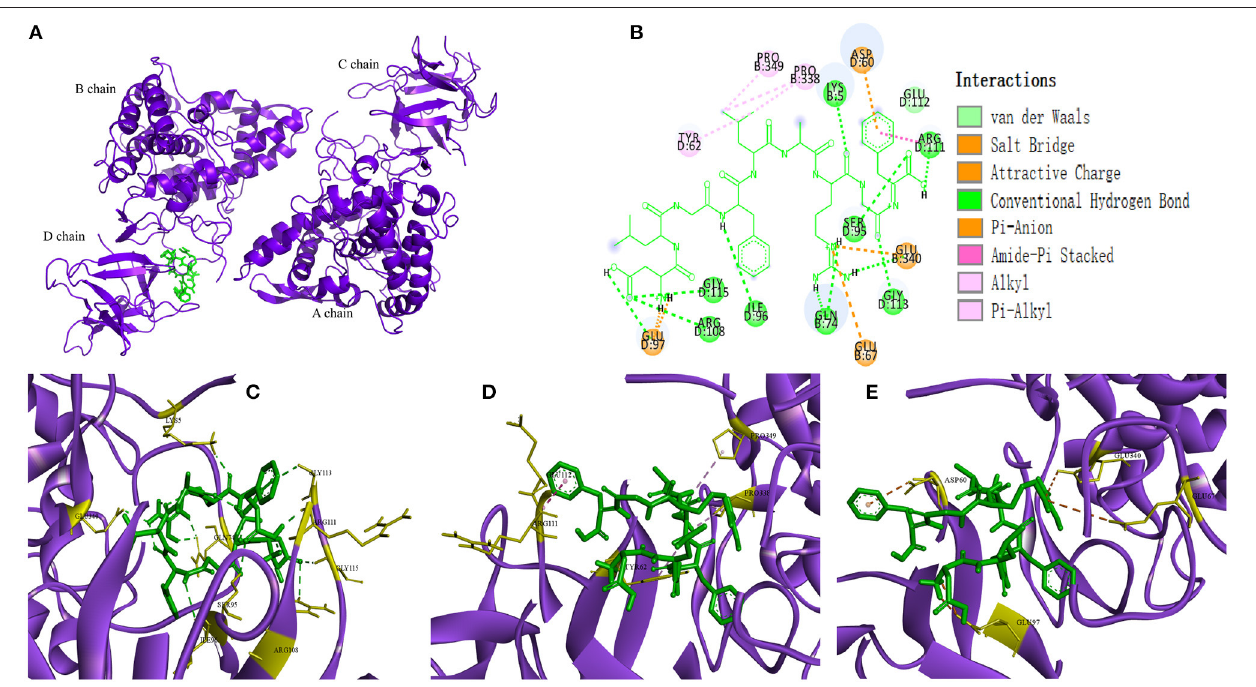
FIGURE 5 | Predicted binding mode of DLGFLARGF and tyrosinase (A,B) . Hydrogen bond formed by DLGFLARGF and amino acid residues of tyrosinase (C) . Hydrophobic interaction between DLGFLARGF and amino acid residues of tyrosinase (D) . Electrostatic interaction between DLGFLARGF and amino acid residues of tyrosinase (E)